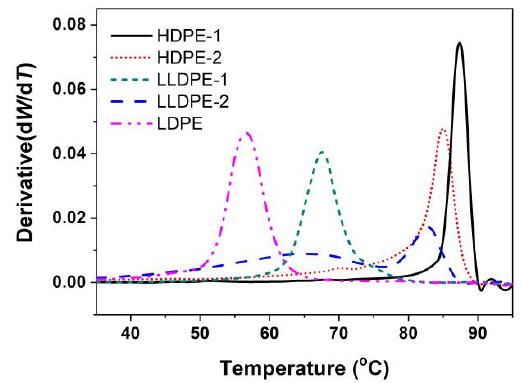
Figure 2. CRYSTAF pro fi les of the neat HDPE, LLDPE, and LDPE.